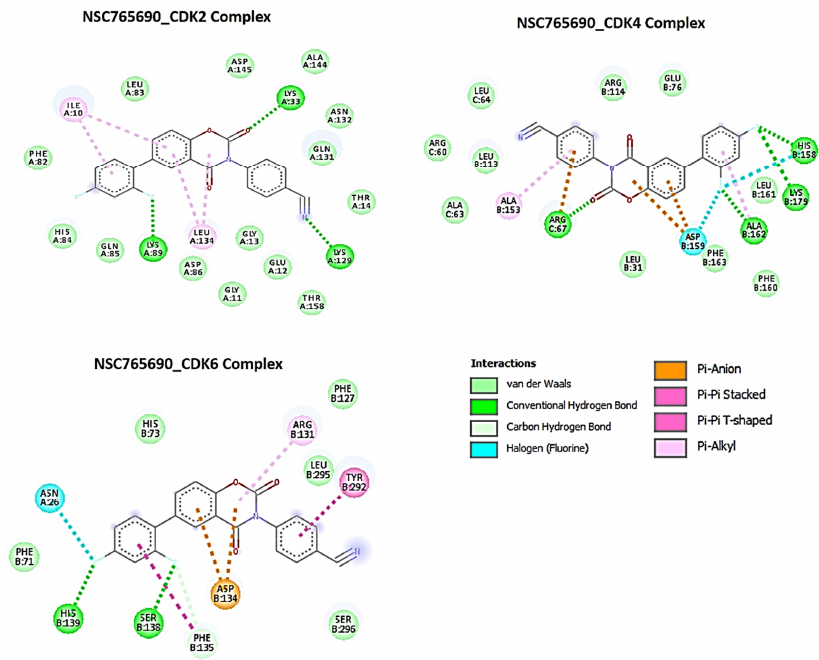
Figure 5. Docking profiles of NSC765690 with CDK2, CDK4, and CDK6. Two dimensional (2D) representations of ligand– receptor interactions occurring between NSC765690 and the target receptors (CDK2/4/6). The deep-green color indicates the strongest ligand–receptor interaction (due to conventional hydrogen bonds) of the best docking pose.